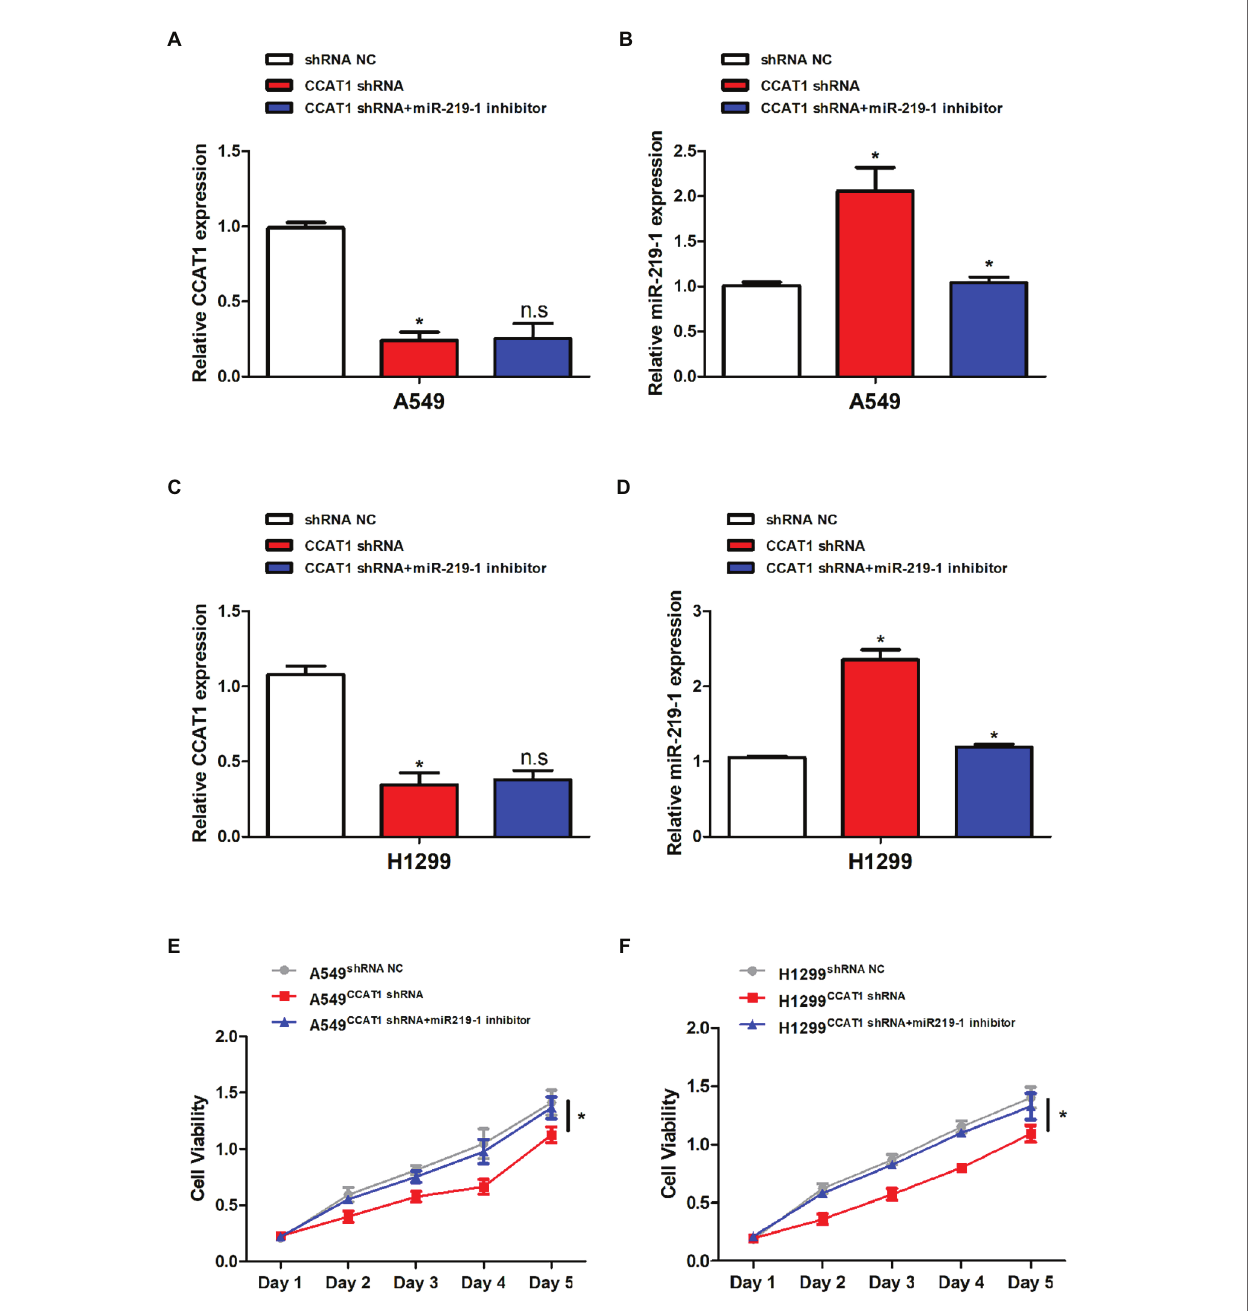
FIGURE 2 | CCAT1 promoted cell proliferation by targeting miR-219-1. (A,C) The relative expression of CCAT1 in A549 and H1299 cells transfected with shRNA NC, CCAT1 shRNA, and CCAT1 shRNA+ by the miR-219-1 inhibitor by quantitative real-time PCR (qRT-PCR). (B,D) The relative expression of miR-219-1 in A549 and H1299 cells transfected with shRNA NC, CCAT1 shRNA, and CCAT1 shRNA+ by the miR-219-1 inhibitor. (E,F) The effects of CCAT1 knockdown on cell proliferation analyzed by CCK-8 assay. Data are shown as means ± SD. NS, not significant, * p <